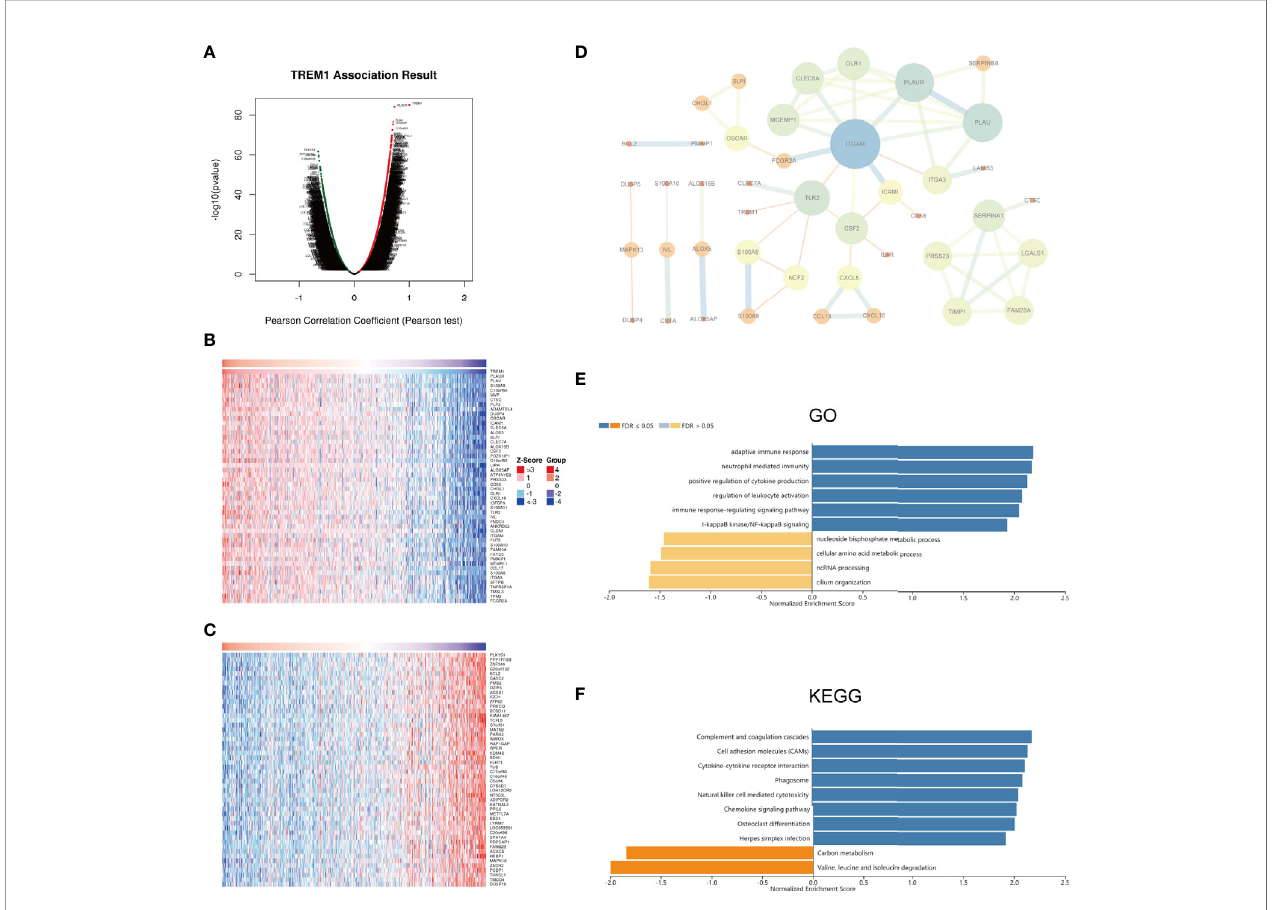
FIGURE 2 | Potential mechanisms of TREM-1 in PTC. (A) Genes highly correlated with TREM-1 identi fi ed by Pearson correlation analysis in the THCA cohort. (B) Heatmaps showing the top 50 genes positively and (C) negatively correlated with TREM-1 in the TCHA cohort. (D) PPI of the top 100 signi fi cantly correlated genes. (E) GO biological process terms and (F) KEGG pathways signi fi cantly enriched in genes coexpressed with TREM-1 in the THCA cohort.